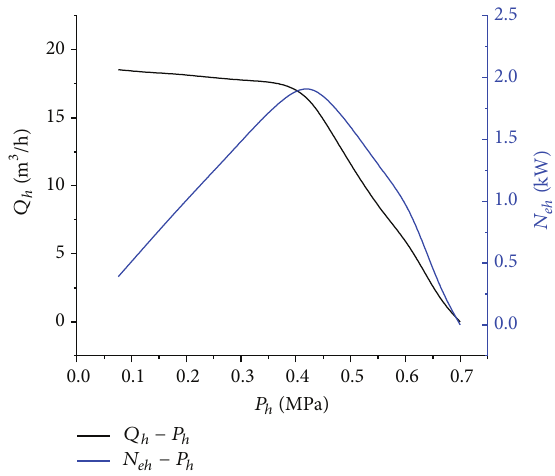
Figure 2: Performance curve of sliding vane pump.